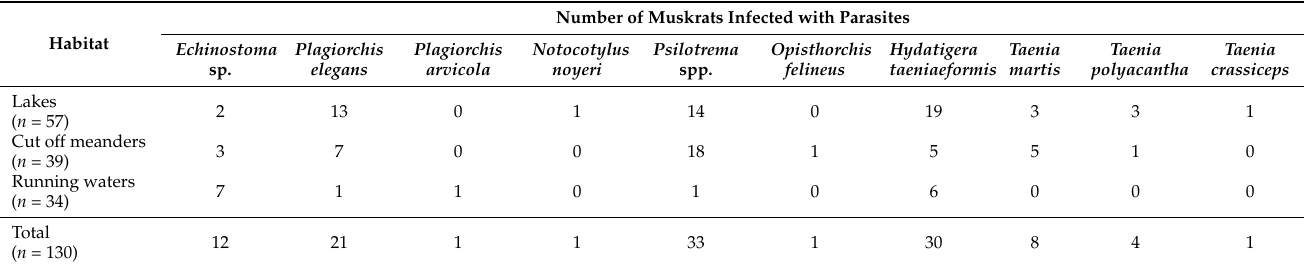
Number of Muskrats Infected with Parasites